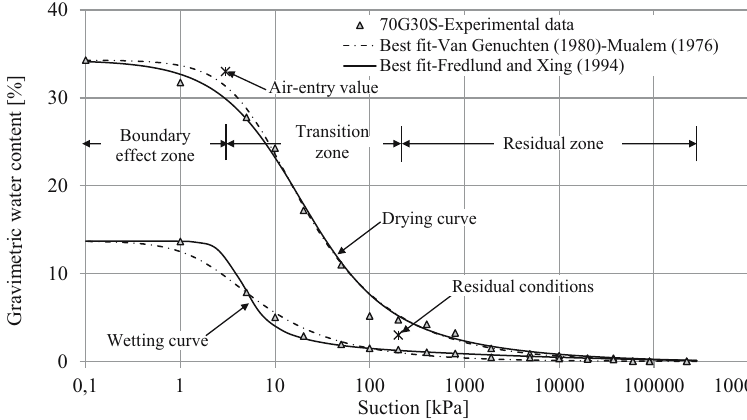
Figure 5: Soil – water characteristic curve, gravimetric water content versus suction for